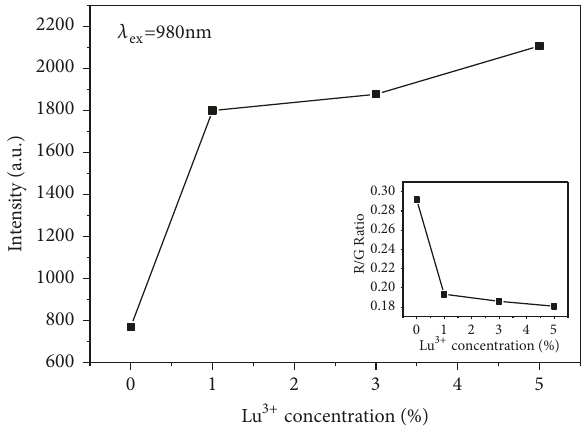
Figure 7: UCPL intensity of (Gd 0.91 phosphors at 546nm (inset is the intensity ratio of red/green emission on Lu 3+ concentration).